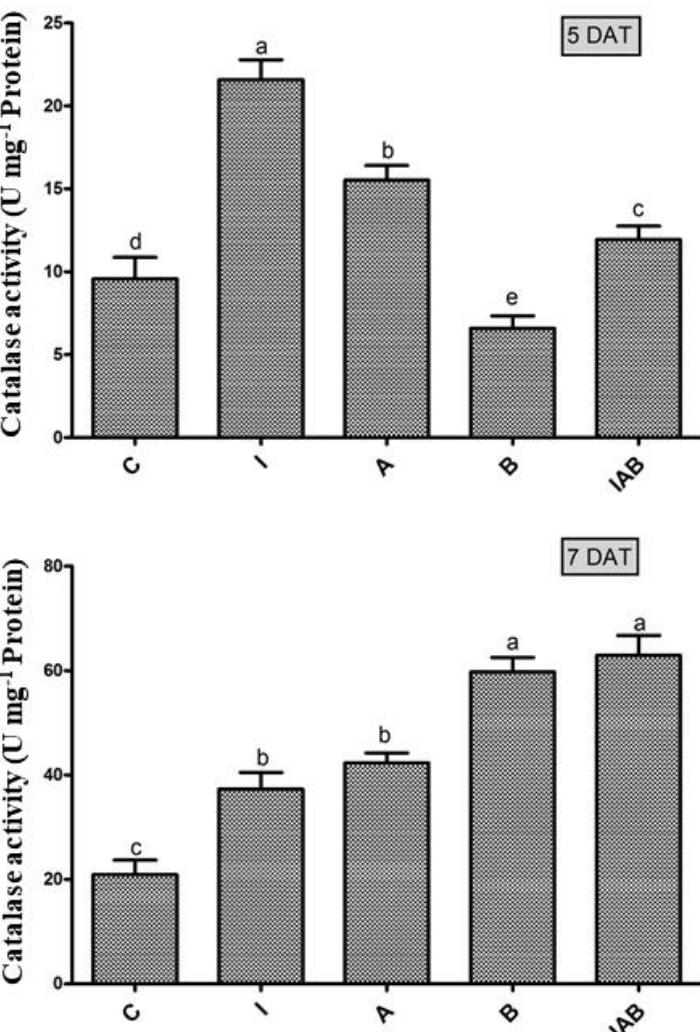
Figure 4. E ff ect of the YNA12 culture filtrate on the regulation of catalase in evening primrose seedlings: Data are presented as the mean ± standard deviation ( n = 3), and significant di ff erences between the control and endophytic YNA12 treatments were analyzed with one-way ANOVA followed by Duncan’s multiple range test ( p < 0.05).